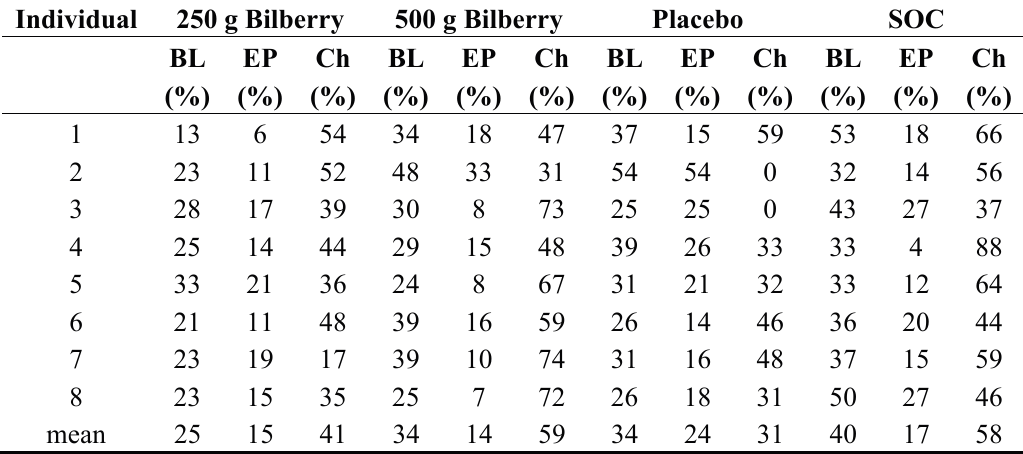
Table 1. Baseline and study end point clinical bleeding on probing (BOP) (%) in the bilberry, placebo and standard of care reference groups. (BL = baseline, EP = study endpoint, Ch = change, SOC = standard of